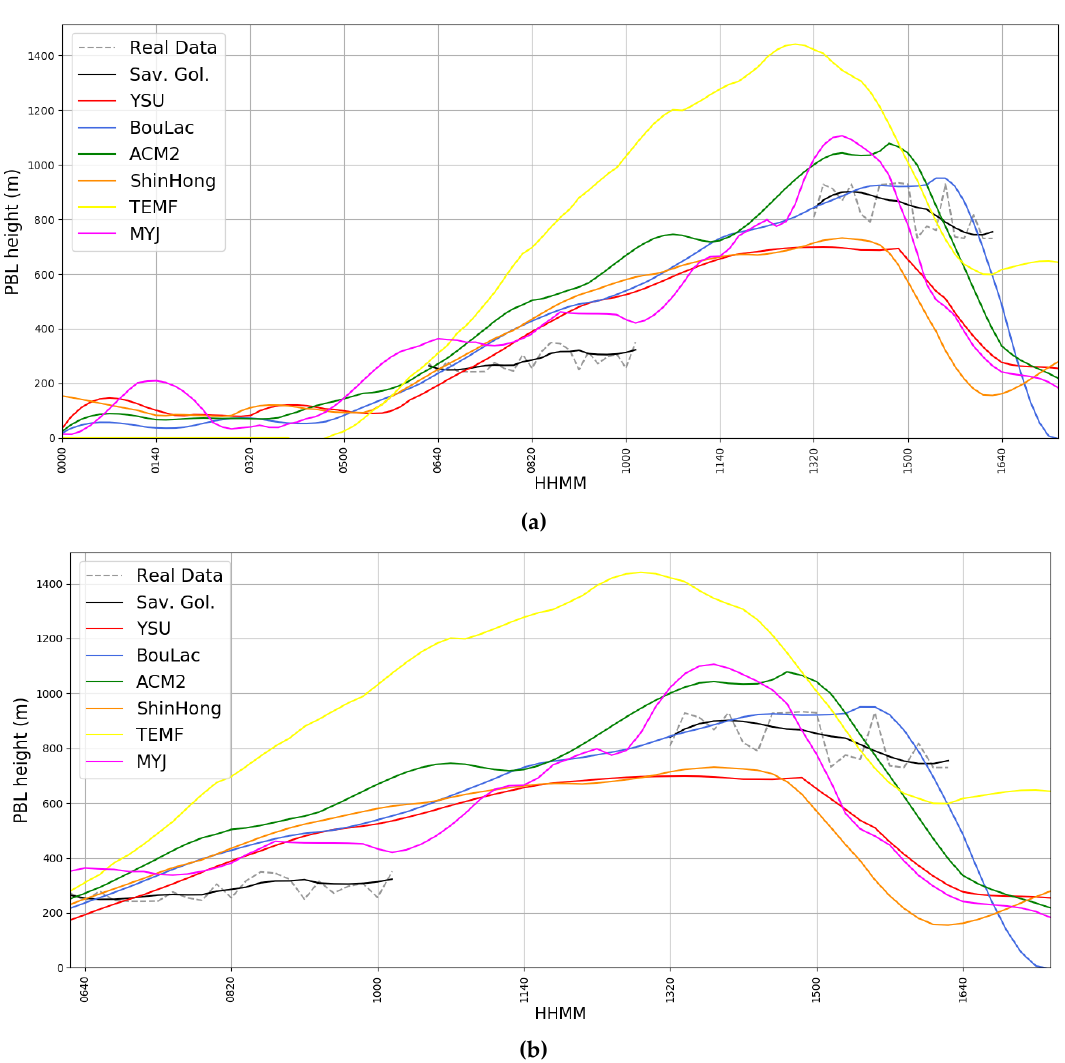
Figure 9. ( a ) Simulated PBLH timeseries compared with lidar-retrieved PBLH timeseries, 04 / 04 / 2016, dotted grey: real data, black: Savitsky–Golay smoothing of real data, red: simulated data with YSU parametrization, blue: simulated data with BouLac parametrization, green: simulated data with ACM2 parametrization, orange: simulated data with ShinHong parametrization, yellow: simulated data with TEMF parametrization, purple: simulated data with MYJ parametrization. ( b ) Simulated PBLH timeseries compared with lidar-retrieved PBLH timeseries, zoomed-in, 04 / 04 / 2016, dotted grey: real data, black: Savitsky–Golay smoothing of real data, red: simulated data with YSU parametrization, blue: simulated data with BouLac parametrization, green: simulated data with ACM2 parametrization, orange: simulated data with ShinHong parametrization, yellow: simulated data with TEMF parametrization, purple: simulated data with MYJ parametrization.